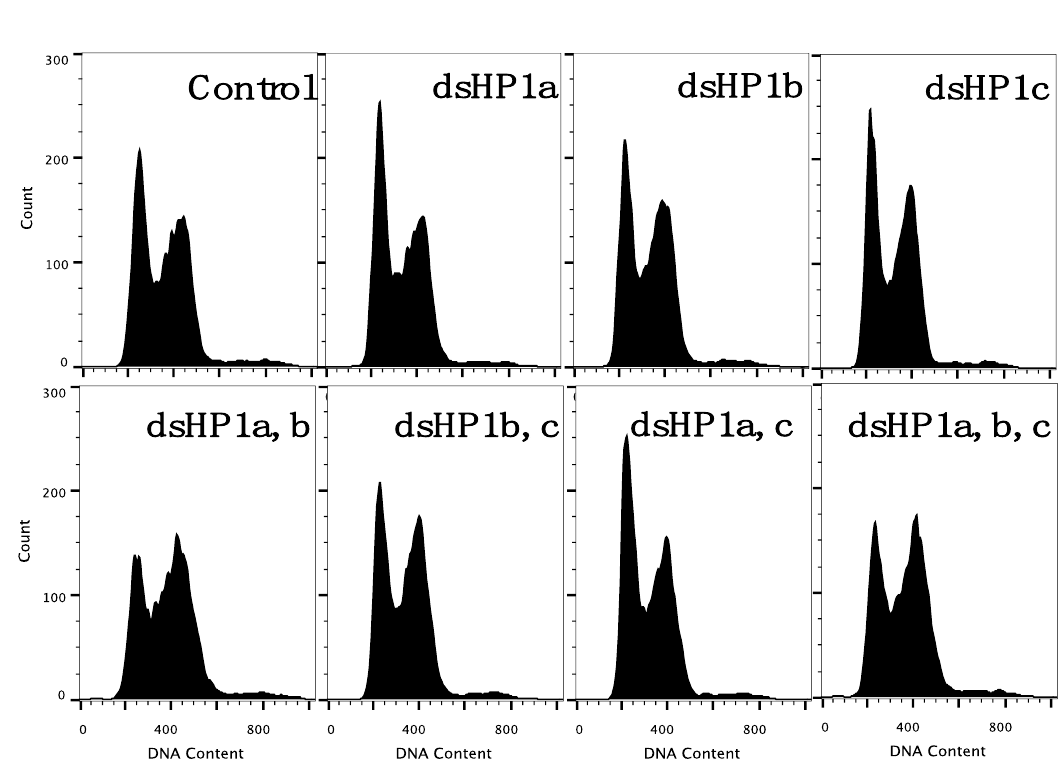
Figure 5. BmHP1s knockdown experiment. ( A ) Confirmation of BmHP1s knockdown efficiency by RT-PCR. BmACTIN was used to normalize the variability in template loading. ( B ) Flow cytometric analysis of the cell cycle in the cells inducing RNAi of BmHP1s for 10 days. Five days after the knockdown, the cells were subcultured on a new plate, at which time dsRNA was also added.